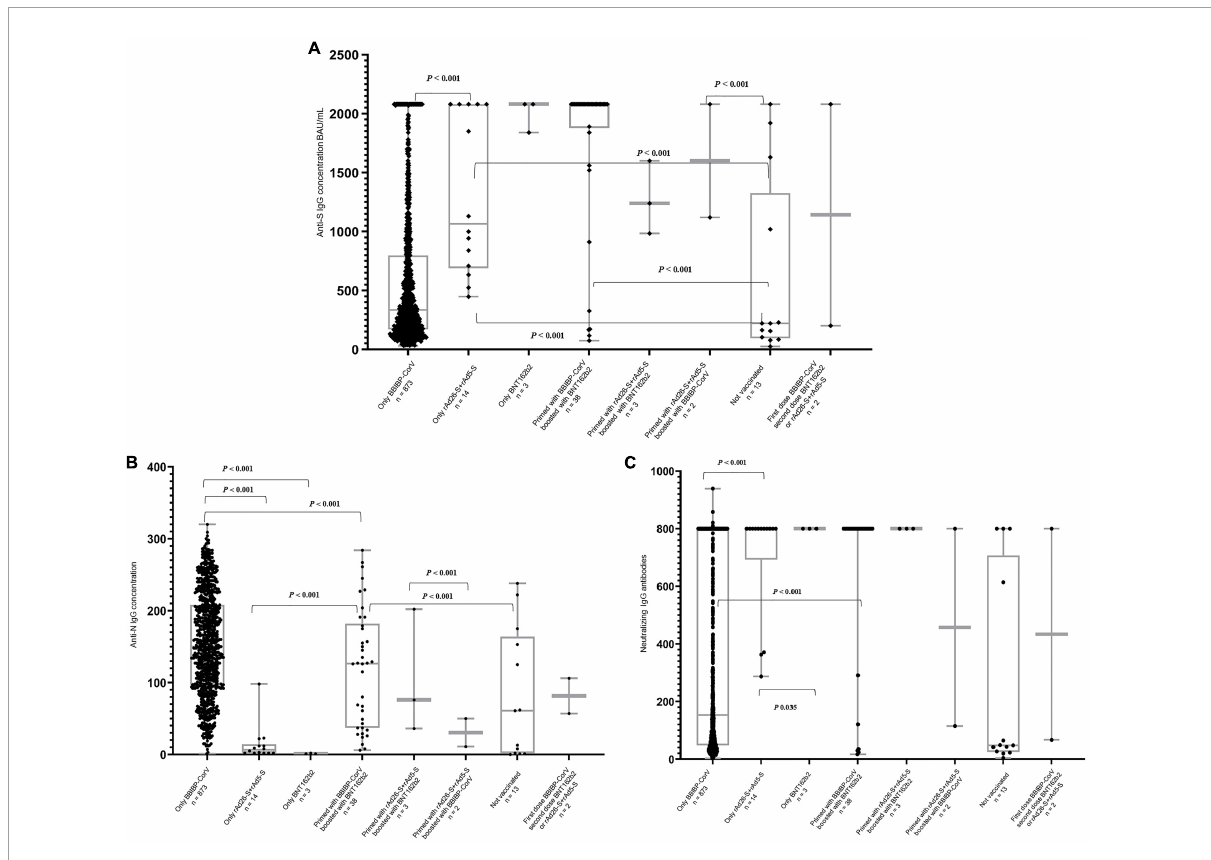
FIGURE1 Distribution of the anti-S (A) , anti-N (B) , and neutralizing (C) IgG antibodies concentration by type of the received SARS-CoV-2 vaccines regardless of the total number of doses. P -values extracted from the Independent-Samples Kruskal–Wallis Test.